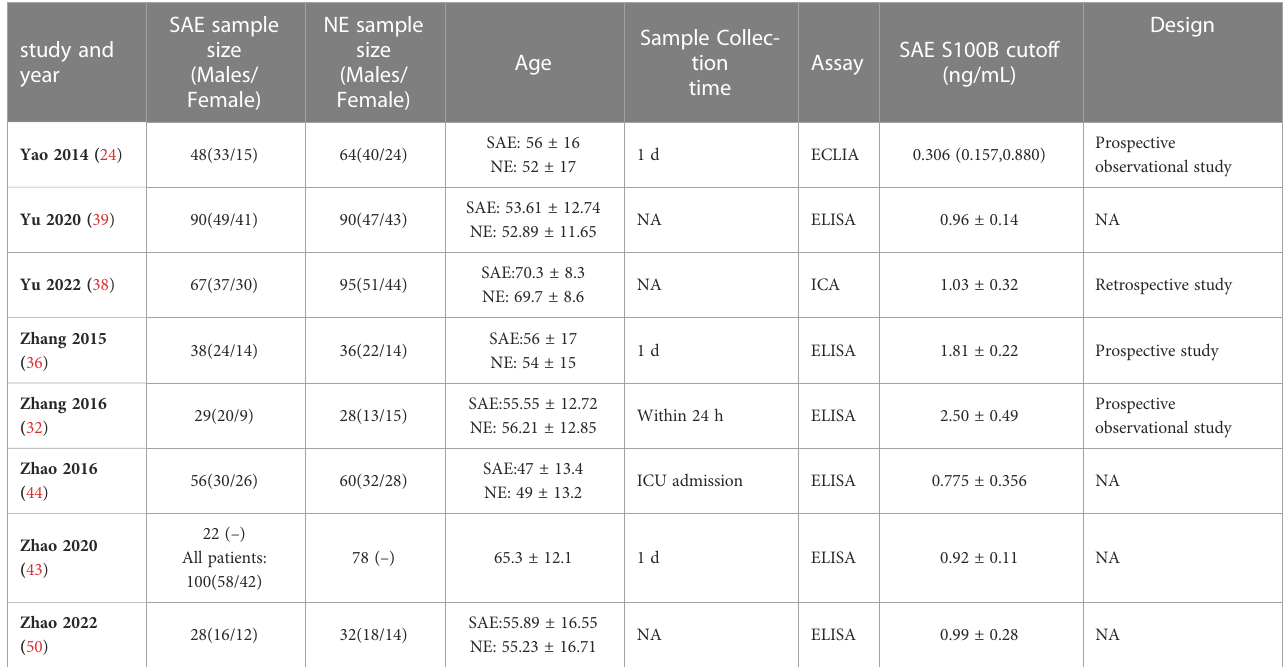
sources of heterogeneity. Furthermore, the combined results of subgroup analyses were statistically signi fi cant and consistent with the overall combined results, showing serum S100B levels in the SAE group were signi fi cantly higher than levels in NE control